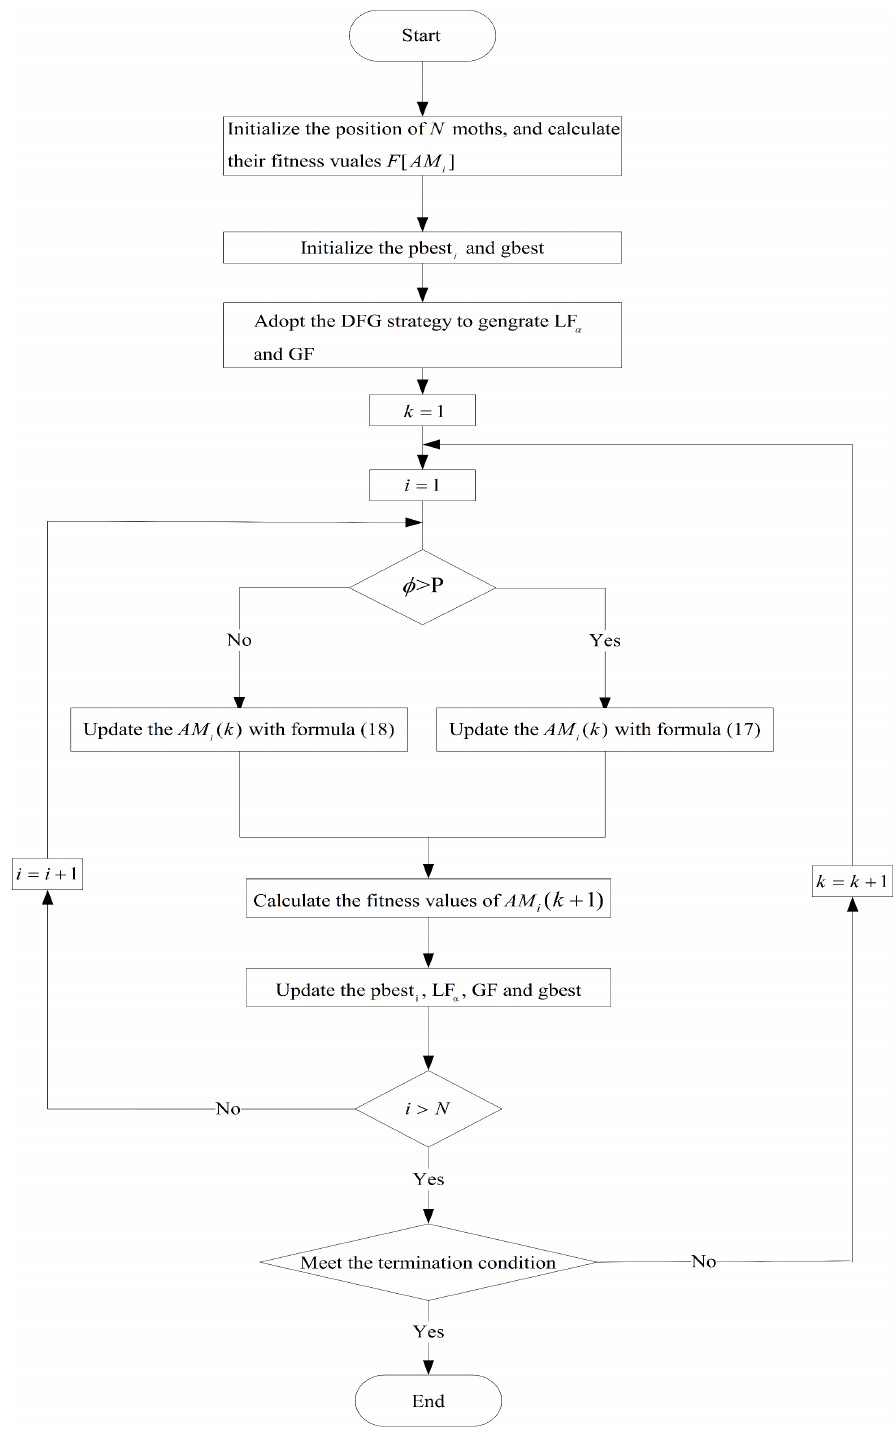
Figure 3. Flow chart of the improved moths ‐ flames optimization (IMFO).